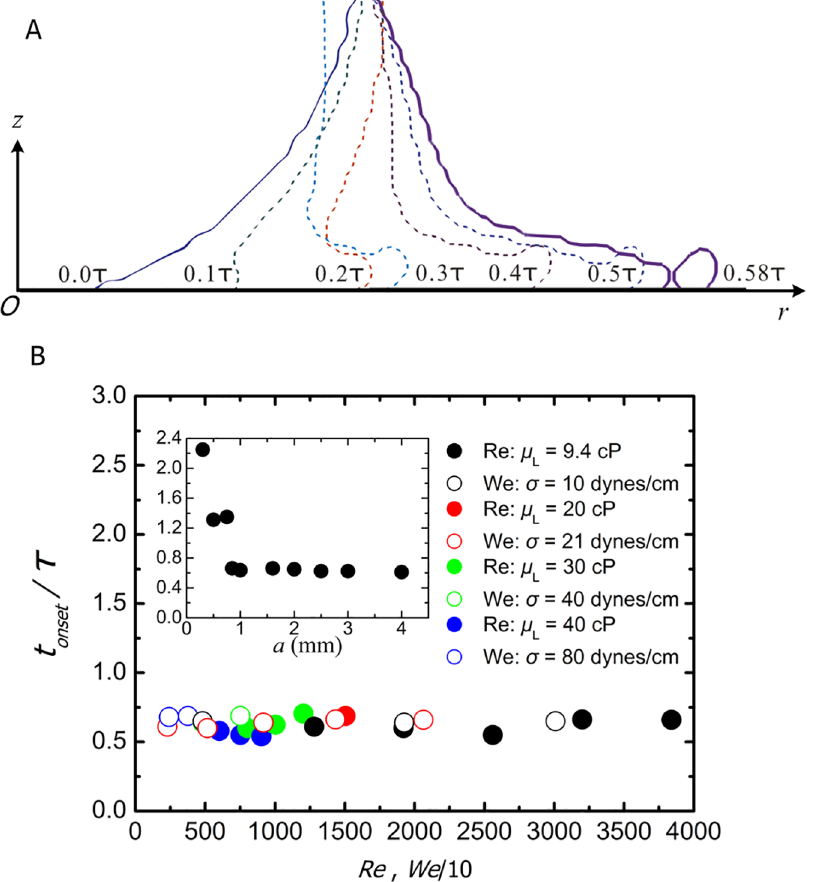
Fig 4. Time evolution of the lamella until splashing emerges. A. Shape evolutionfor the impact at speed U 0 = 8 m/s and the liquiddynamic viscosity μ L = 40 cP. The other parameters are the same as that for Fig 3. B. Onset time for the splash t onset as a function of Re (solid symbols) and We (open symbols), as the drop radius is fixed at a = 1.6 mm. To make the two relationships plotted in one figure, the horizontalaxis is 10 times reducedfor We . The different colors correspond to different liquiddynamic viscosity μ L = 9.4 to 40 cP and surface tension σ = 10 to 80 dynes/cm. The inset plots t onset vs drop radiusat the same impact conditionas that for Fig 3 except that U 0 = 10 m/s.